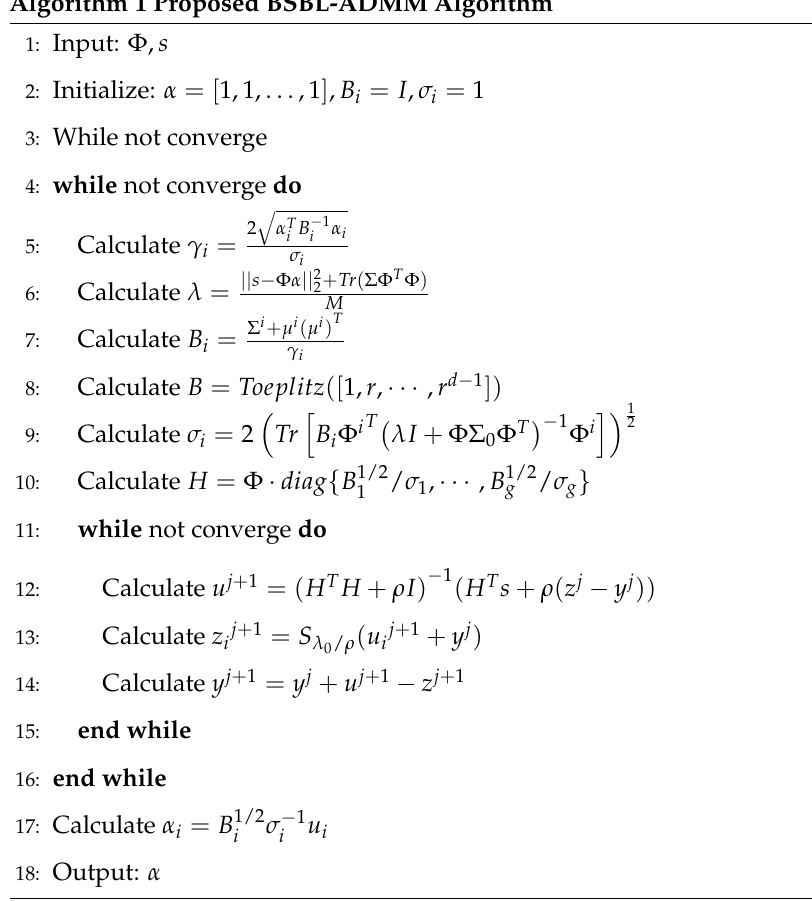
Algorithm 1 Proposed BSBL-ADMM